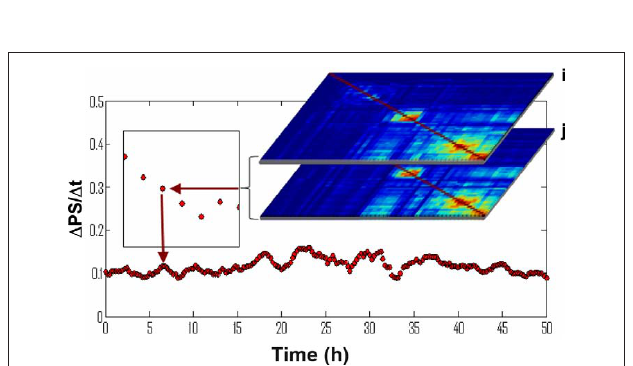
Figure 9 | Phase synchronization matrices and synchronization networks. In (A) we show a typical phase synchronization dendrogram for a specific 15 min window prior to NCS addition, for one of the WT networks (see SI3). The distinct synchronization cliques are the clusters of highly synchronized neurons. In (B) we show the corresponding synchronization networks presented on top of the real space diagram of the MEA electrodes ( Figure A1 in Appendix). Here, the phase synchronization is represented by color coded lines between the nodes (neurons). The neurons are color coded (blue for low and red for high) according to their centrality. One clique is marked by a red square in (A) , the same clique is now marked by a red ellipse in (B) . This shows that the synchronization clique is indeed formed by proximate neurons. The synchronization endurance is illustrated in (C,D) by the similarity of the synchronization matrices [using the same dendrogram order as in (A) ], evaluated at different time windows before NCS treatment (C) and after (D) . Performing similar comparison for the Atm − / − networks reveals reduced synchronization persistence – the dendrogram obtained post NCS (F) is somewhat different than the one obtained pre NCS addition (e) .